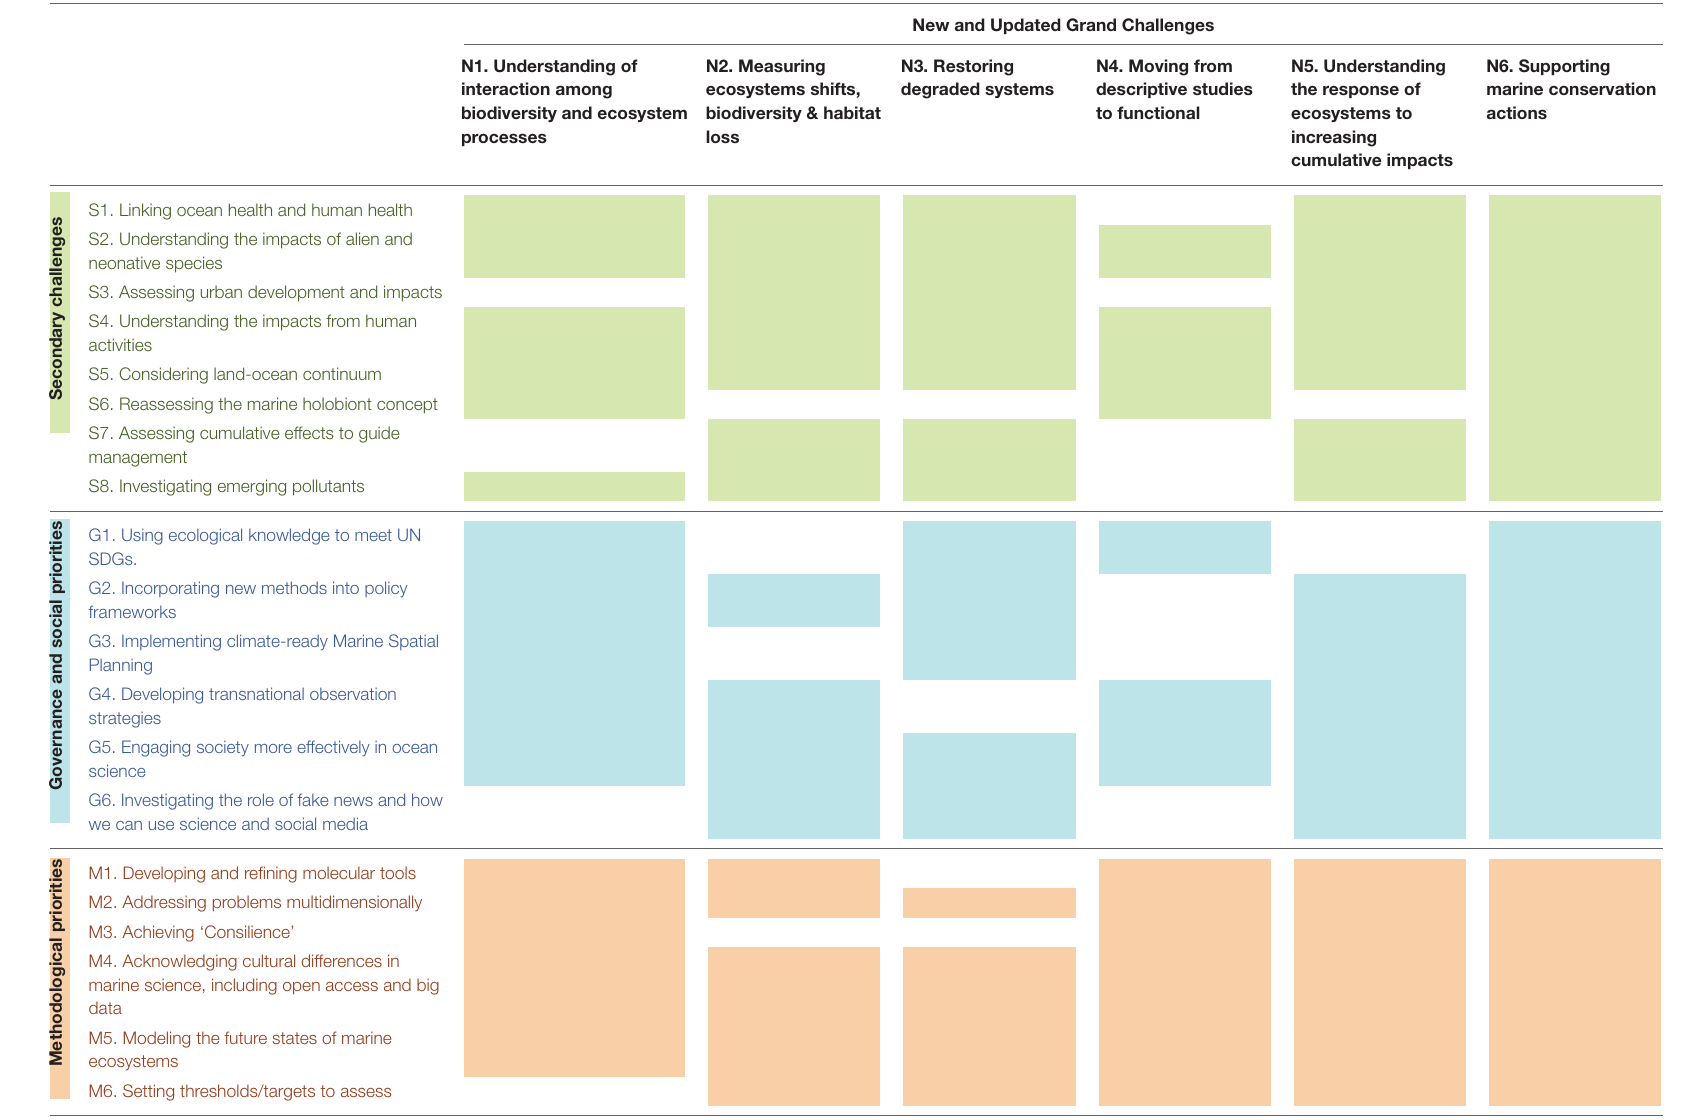
TABLE 2 | Summary of the new (N) and updated Grand Challenges faced by marine ecosystems in the next decade, as identified by the editorial board of Frontiers in Marine Science (section Marine Ecosystems Ecology), which need to be addressed from science in different